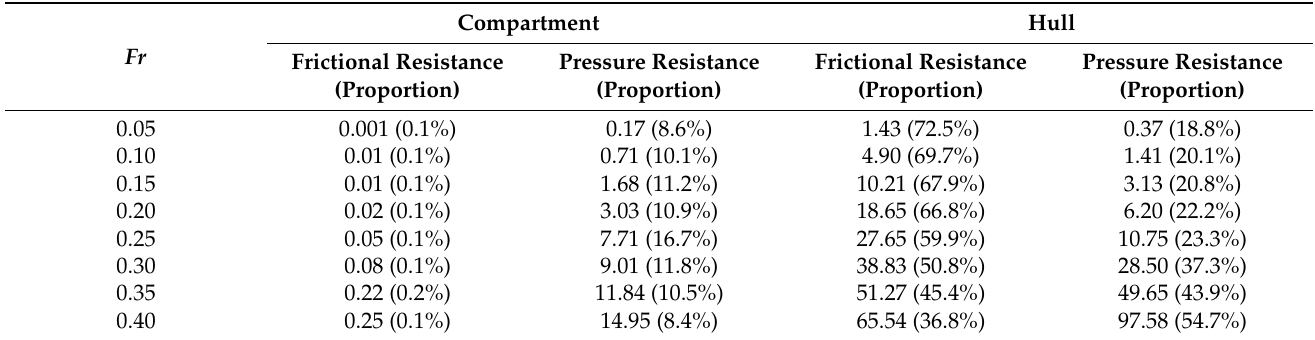
Table 11. Resistances of compartment and hull and proportions to the total resistance under symmet- rical flooding (unit: